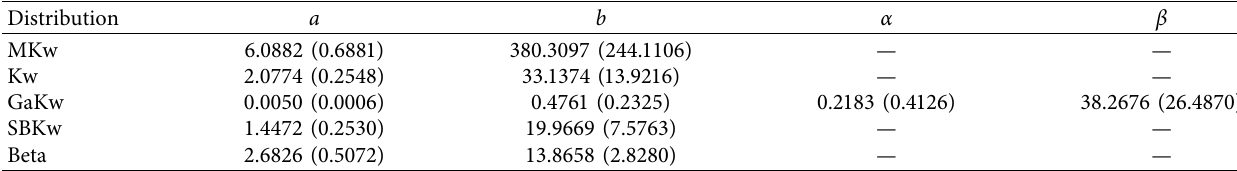
Figure 6: Plot of (a) VaR and (b) ES of the MKw model for some parametric Table 7: MLEs and their standard errors (in parentheses) for data set 1.